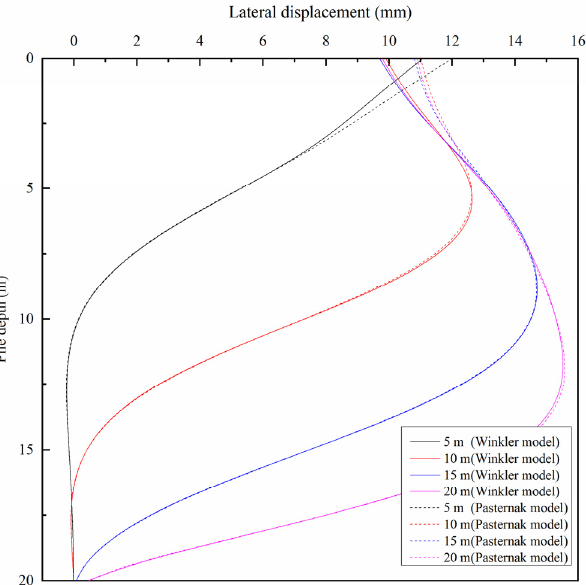
Figure 13. Comparison of calculation results between Winkler foundation model and Pasternak foundation model.